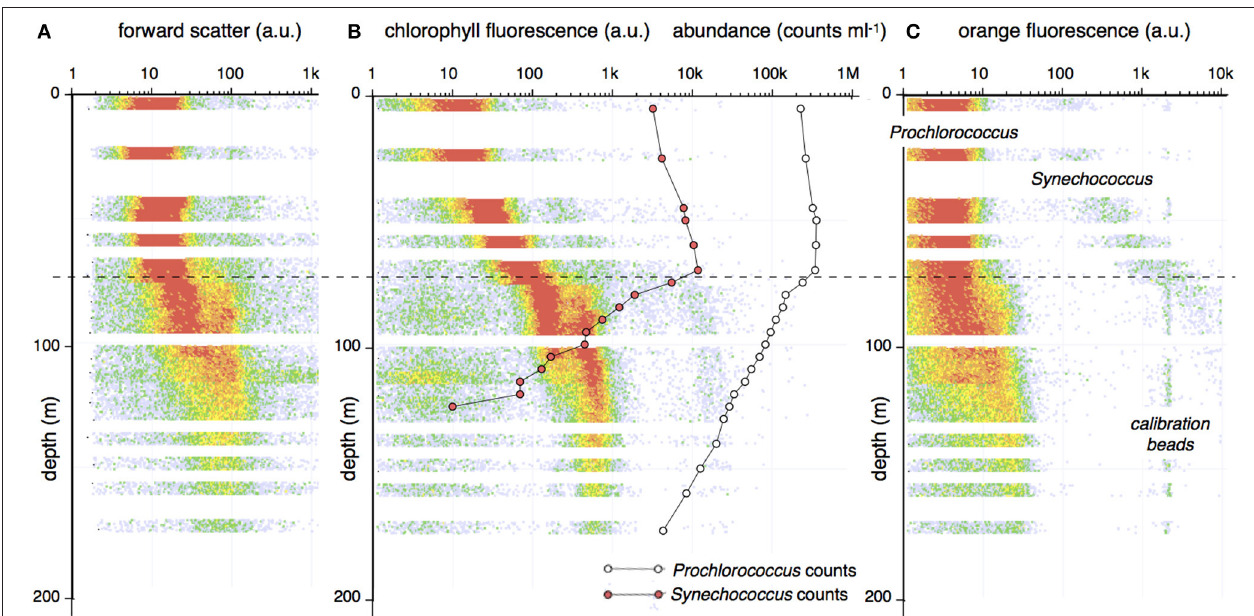
FIGURE 1 | A characteristic flow cytometry depth profile from Station ALOHA, October 2013. Samples were collected at 5-m increments. For each sample, the scatter and fluorescence properties were determined for all cells (particles > 200nm) present in 100 µ L of seawater. A depth profile was generated by distributing the cells in a 5-m thick layer of depth/parameter bins according to the measurement properties. The color of each bin indicates the number of events with that property. The vertical axis represents depth. The horizontal axis indicates measurement values in logarithmic units (64 channels/decade). The traces represent: (A) Forward (low angle) light scatter; (B) Red fluorescence (692 ± 20nm; a proxy for chlorophyll). (C) Orange fluorescence (570 ± 20nm; a proxy for phycoerythrin). The center panel also shows the abundance of Prochlorococcus (open circles) and Synechococcus (red circles) expressed as cells mL − 1 . Cell abundance and chlorophyll fluorescence are both indicated in logarithmic (arbitrary) units on the same scale. The dotted line indicates the approximate position of the top of the permanent pycnocline. Fluorescence and cell count profiles show an abrupt change at the edge of the